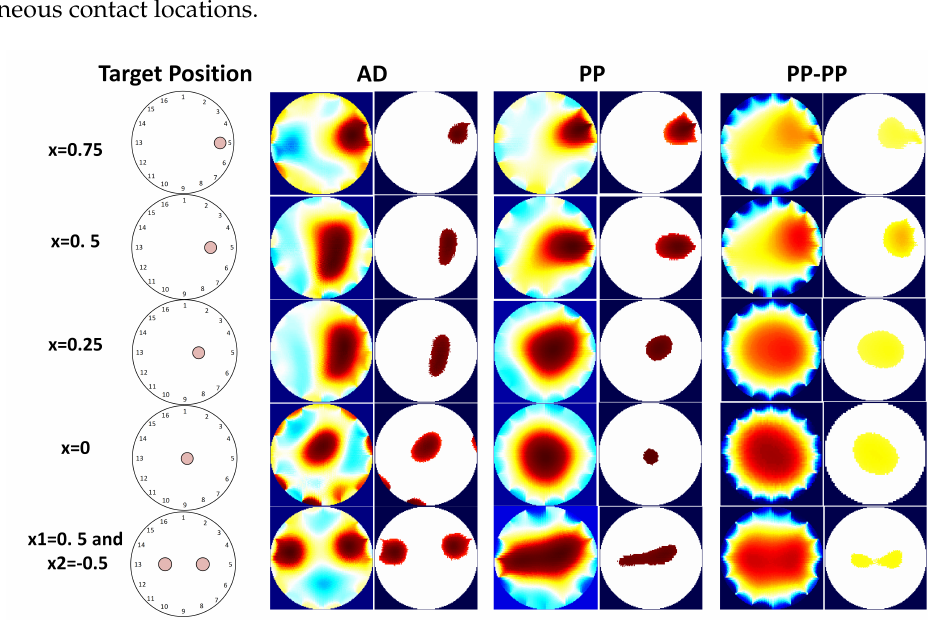
Figure 8. On the left, the real contact locations are shown, and for each one the reconstructed and processed images in the case of AD, PP and PP-PP pattern are presented. Table 4. Performance parameters from experimental